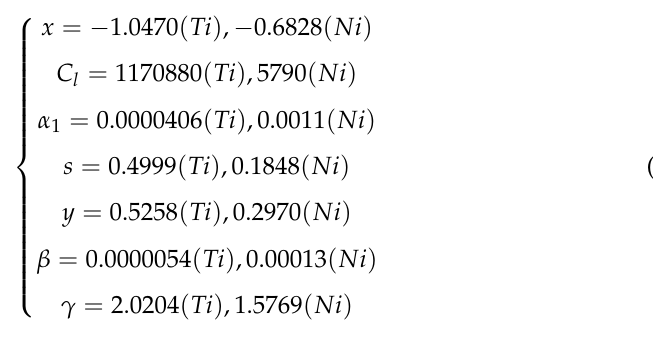
Table 7. Tool life results of the experiments in Step B